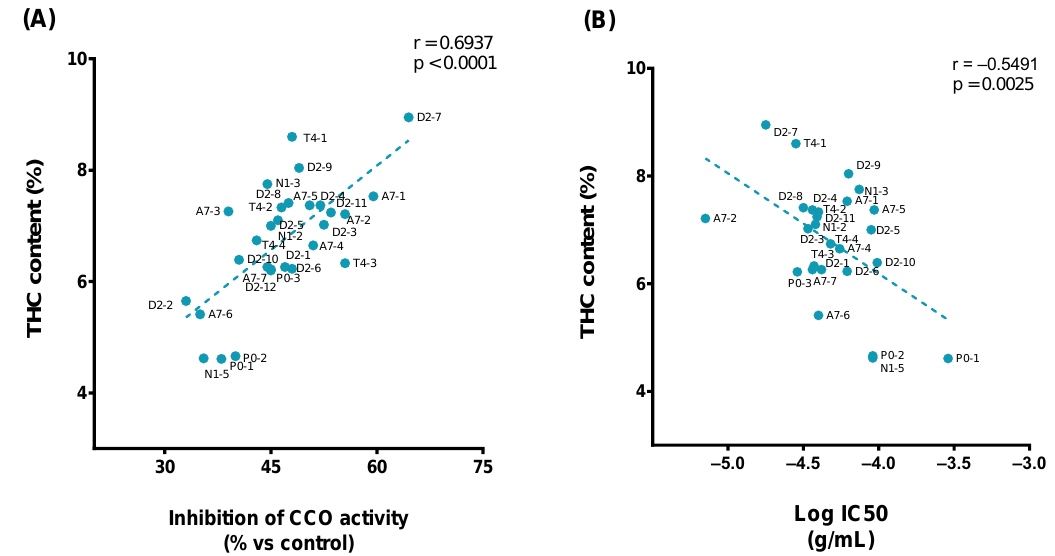
Figure 5. Pearson correlation plot of the ( A ) THC content (% relative area) vs. inhibition effect of 1 × 10 − 4 g/mL of extract (%). ( B ) THC content (% relative area) vs. pIC50. We also evaluated the effect of pure THC and CBD on the CCO activity (Figure 6). The results showed a saturation of the inhibitory activity of CBD in concentrations above 1 × 10 −4 .6 g/mL and THC above 1 × 10 −5 .3 g/mL, which is consistent with the Cannabis sativa extracts´ effect on the CCO activity where the saturation at 1 × 10 −4 g/mL of extract was observed.